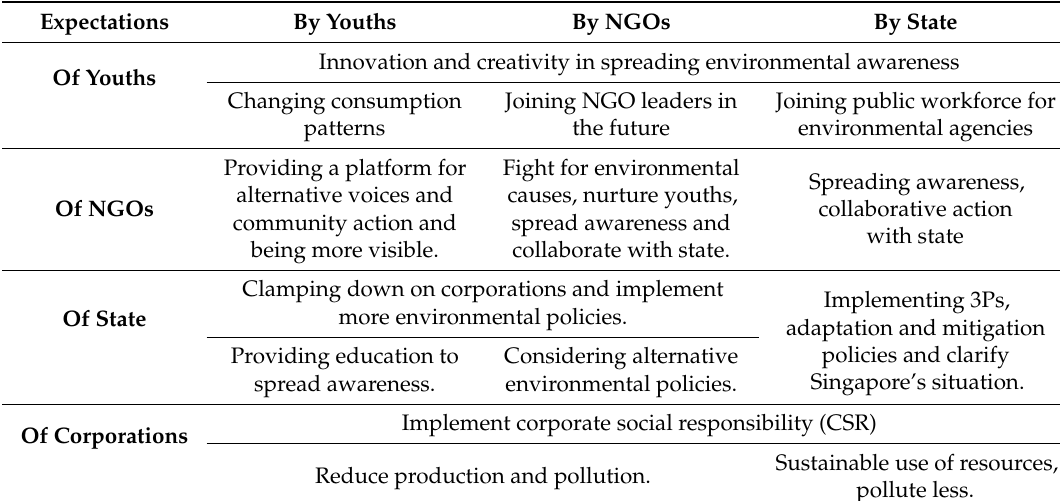
Table 4. Stakeholders’ expectations of one